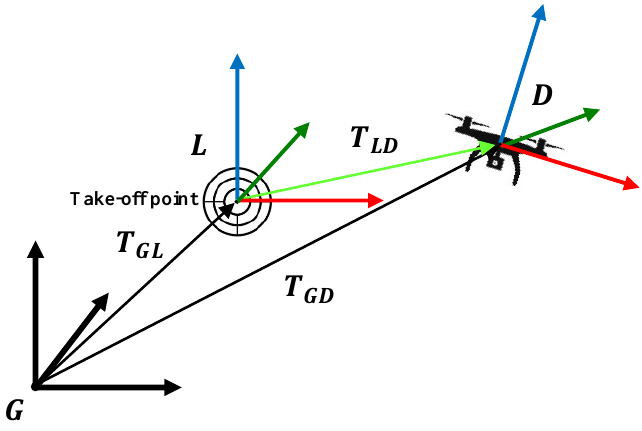
Figure 6. Full transformation